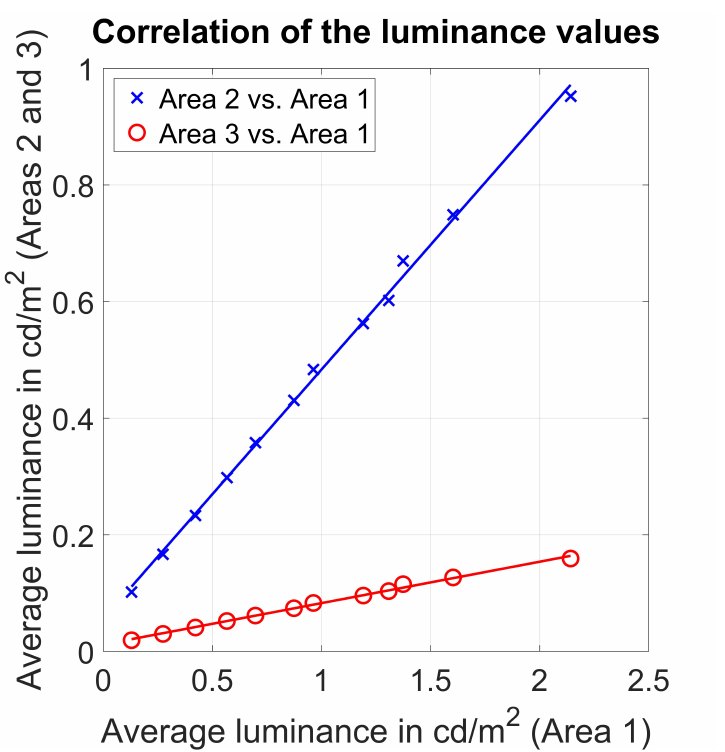
Figure 5. Average luminance values of the mid-field (crosses) and far-field area (open circles) in relation to the average near-field luminance. The linear relation between the luminances of these areas is clearly shown and statistically significant ( p < 0.001).